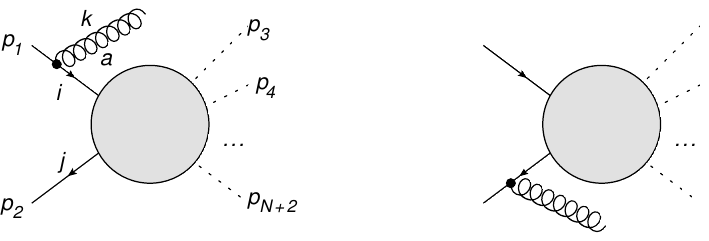
Figure 4 . Diagrams contributing to the spin-dependent part of the NLO cross-section, where (cid:15) denotes the magnetic moment coupling of the gluon to the spin of the